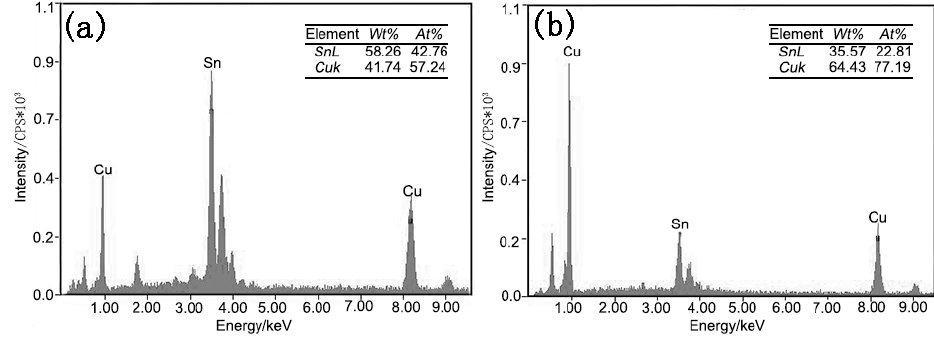
Figure 3. EDS analysis result of the point “A” and “B” in Figure 2. ( a ) point “A”; ( b ) point “B”.